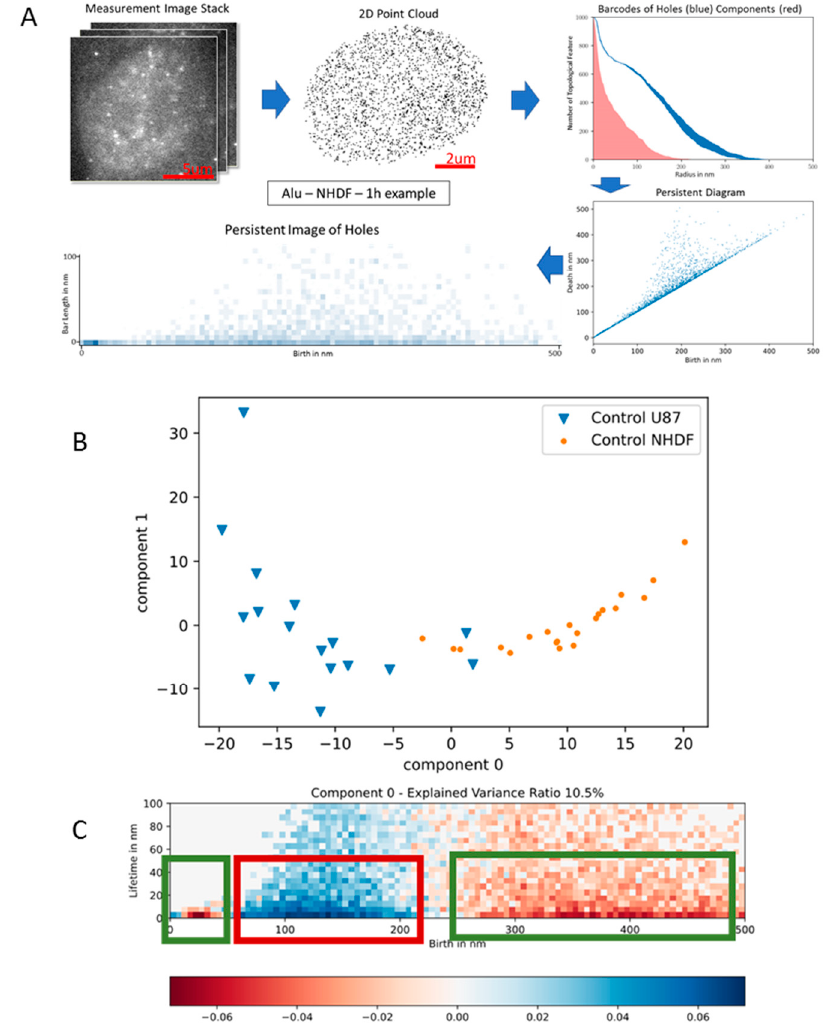
Figure 17. ( A ) An example of persistent homology workflow. After the measured image stack is converted into a 2D point cloud, persistent homology is applied. The results are represented as barcodes, showing each component (red) and hole (blue) as one bar. The persistent diagram, where each hole is shown as a point with birth and death as coordinates, is an equivalent representation. To vectorize the persistence diagram, it is converted into a persistent image by laying a grid over it and counting the holes in each grid cell. ( B ) After principal component analysis, the ALU networks of two cell lines can be separated and ( C ) the sizes of the holes of the network meshes can be determined (green rectangles: U87 glioblastoma cell line; red rectangle: NHDF fibroblast cell line).